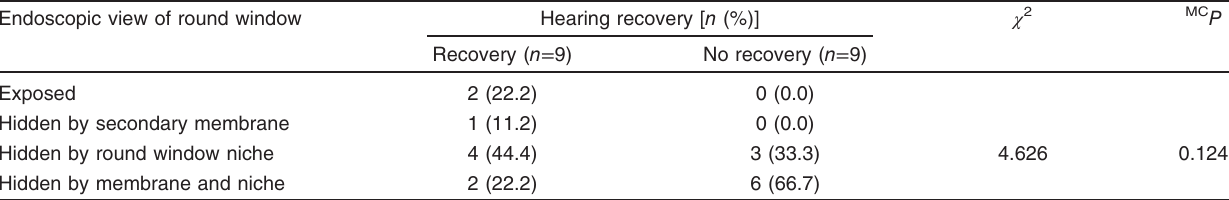
Table 5 Relation between hearing recovery and endoscopic view of the round window ( N = 18) Endoscopic view of round